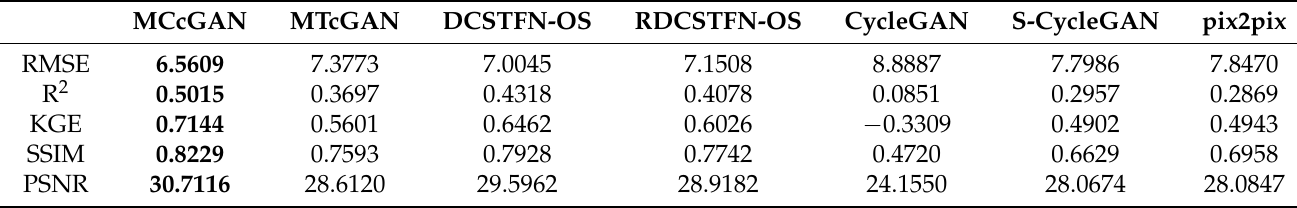
Table A3. The evaluation metrics of different methods for the blue band in Area B at Time III (the bold result is the best among the different metrics).